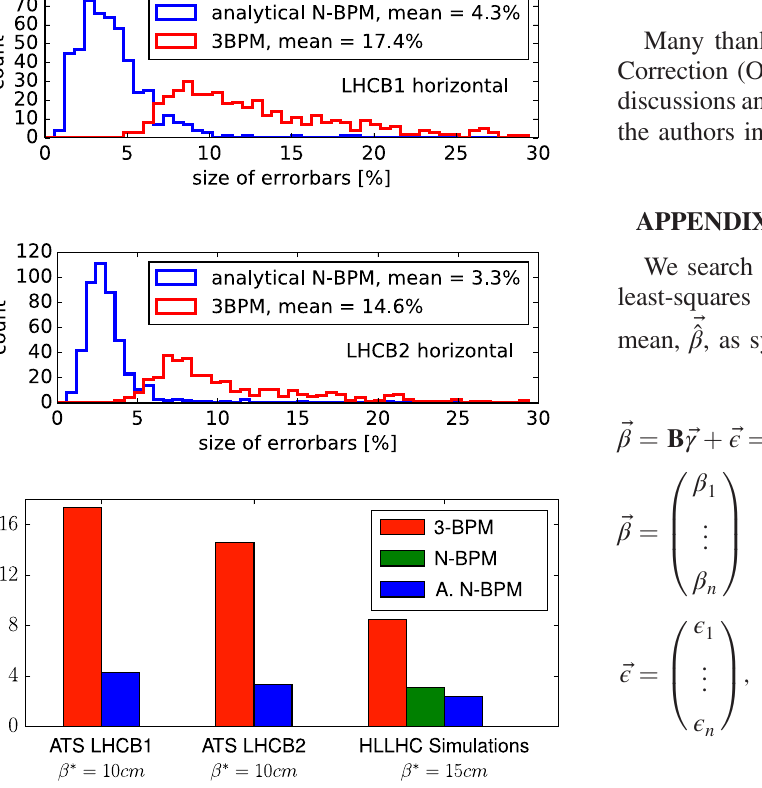
FIG. 8. A comparison of the error bars of the β (cid:1) ¼ 10 cm optics of the October 2016 MD. Top: histogram of the error bars of beam 1. Center: histogram of the error bars of beam 2. Bottom: mean of the size the error bars. The mean of the analytical N-BPM method is a factor 4 more accurate than the 3 BPM method. The third set of values shows the mean of the error bars of the simulations as shown in Fig. 6 but for the whole